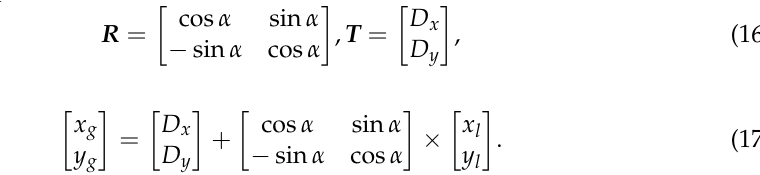
where R and T represent the rotation matrix and translation matrix, respectively, where the specific relationship